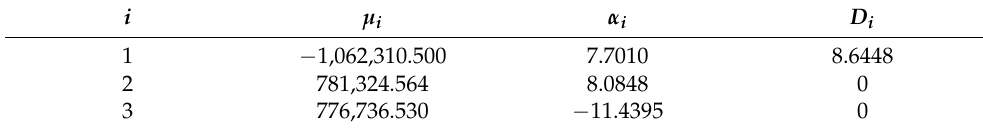
Table 3. Material properties of the specimens. Coefficients of Ogden’s model.